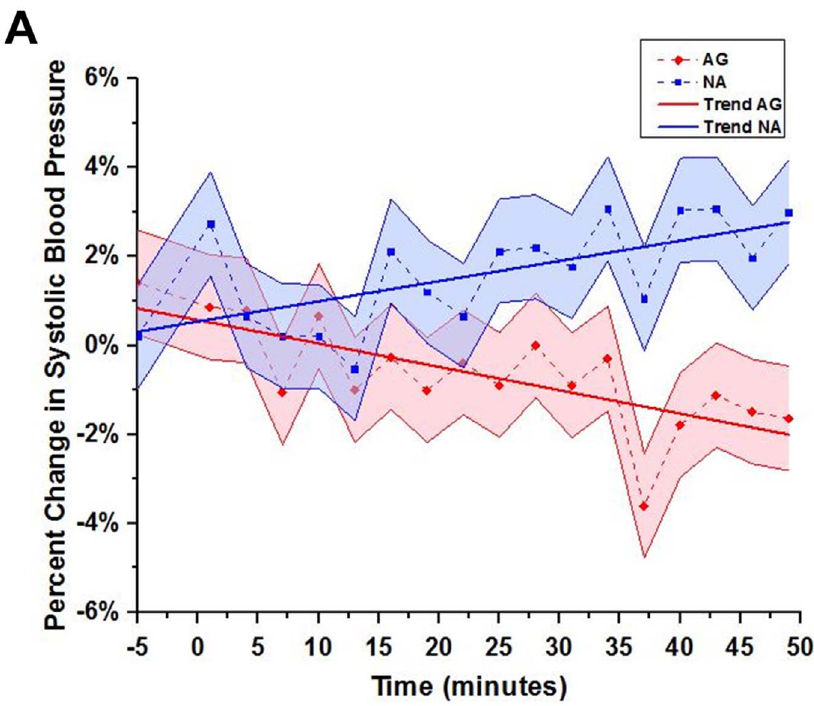
Figure 1. Systolic blood pressure response to violent media. Ag (red) individuals show reduction in systolic blood pressure while watching the violent media versus Na (blue) individuals who show progressive increase in systolic blood pressure. Systolic blood pressure measures were averaged for each group at each time point and a percent change and a trend line were calculated (Y-axis). Error bars (joined and filled) reflect the standard deviation of the data that are presented.